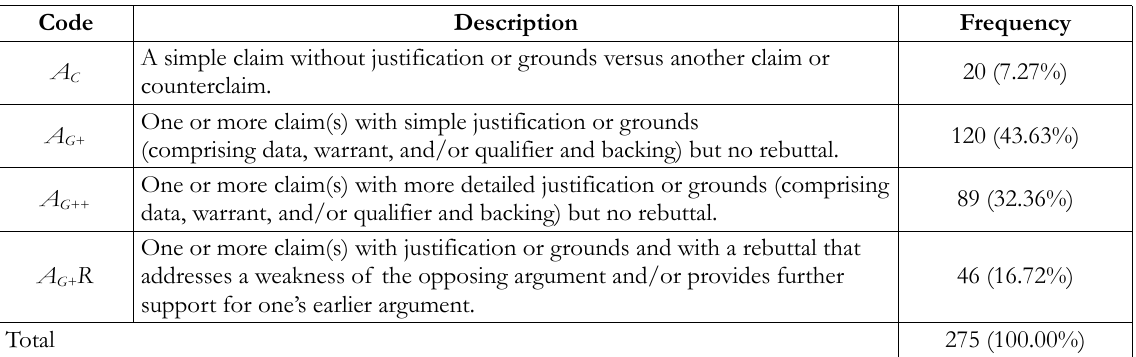
Table 6. Students’ scientific argumentation in the Dcision making